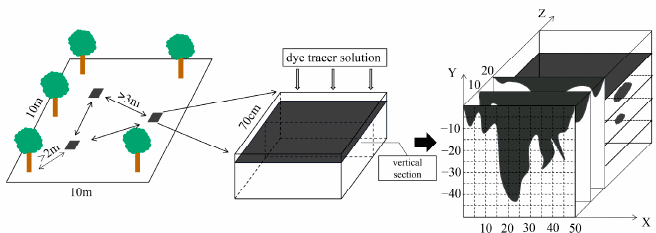
Figure 1. Dye-tracing